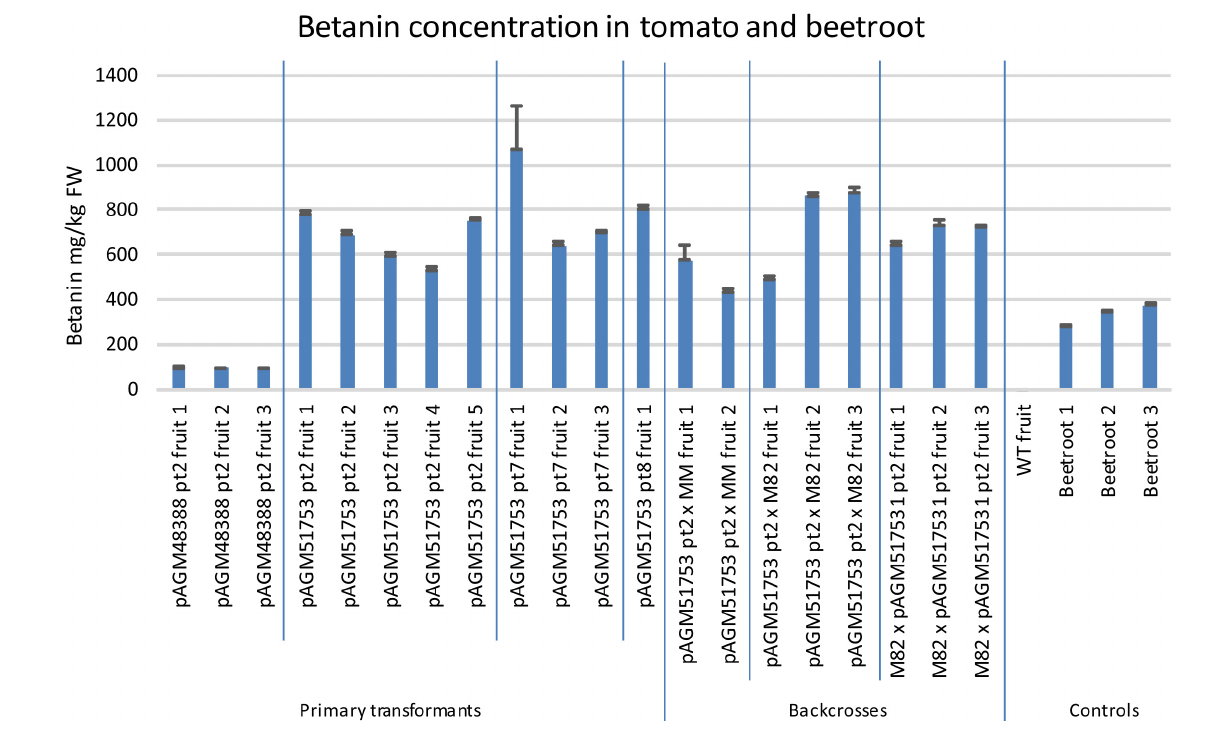
FIGURE 6 | Betanin concentration in tomato transformants and in beetroot. Betanin was quantified in several fruits harvested from the primary tomato transformants or from plants obtained from the backcrosses of pAGM51753 transformant 2 with Moneymaker or M82. The fruits were harvested when they were ripe, and were not all harvested on the same date. In addition, a fruit with WT phenotype (lacking betalain) obtained from the M82 × pAGM51753 cross was used a WT control. Betanin content of three beetroots were also measured. For all samples, quantification was done in triplicate from three aliquots of tissue from the same fruit or beetroot. The error bars show the standard deviation of the three